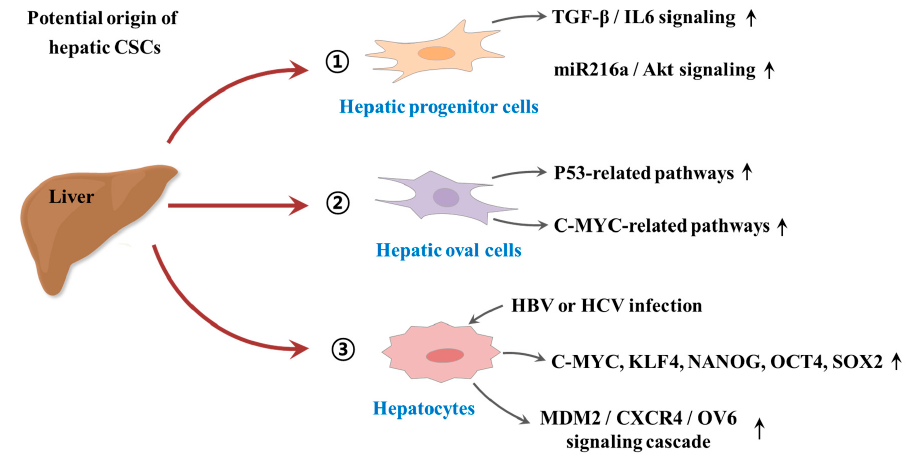
Figure 1. Schematic diagram summarizing the potential origin of hepatic cancer stem cells (CSCs). Hepatic progenitor cells can be transformed into tumor-initiating cells by activation of transforming growth factor beta (TGF β )/interleukin-6 (IL-6)-related signaling and miR216a/Akt-dependent signaling pathways. Hepatic oval cells (HOCs) were involved carcinogenesis of hepatocellular carcinoma (HCC) through p53 and c-myc related signaling pathways. In addition, the infection of hepatitis B or C virus (HBV or HCV) significantly increases the malignant transformation into HCC by enhancing the expressions of CSCs-associated transcription factors or activating MDM2/CXCR4/OV6 signaling cascades. “ ↑ ” means increase.